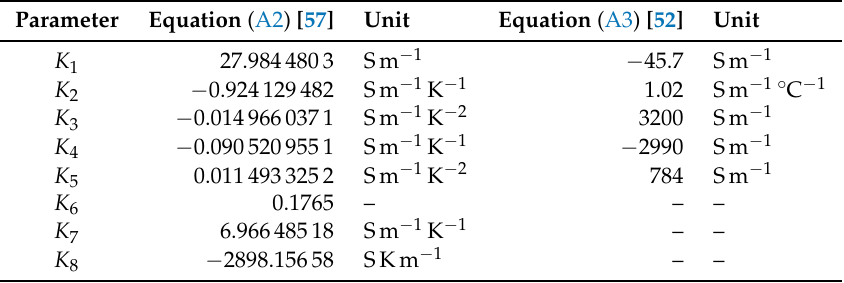
Table A2. Parameters for the calculation of the specific electrolyte conductivities of KOH and NaOH solutions by Equations (A2) and (A3)